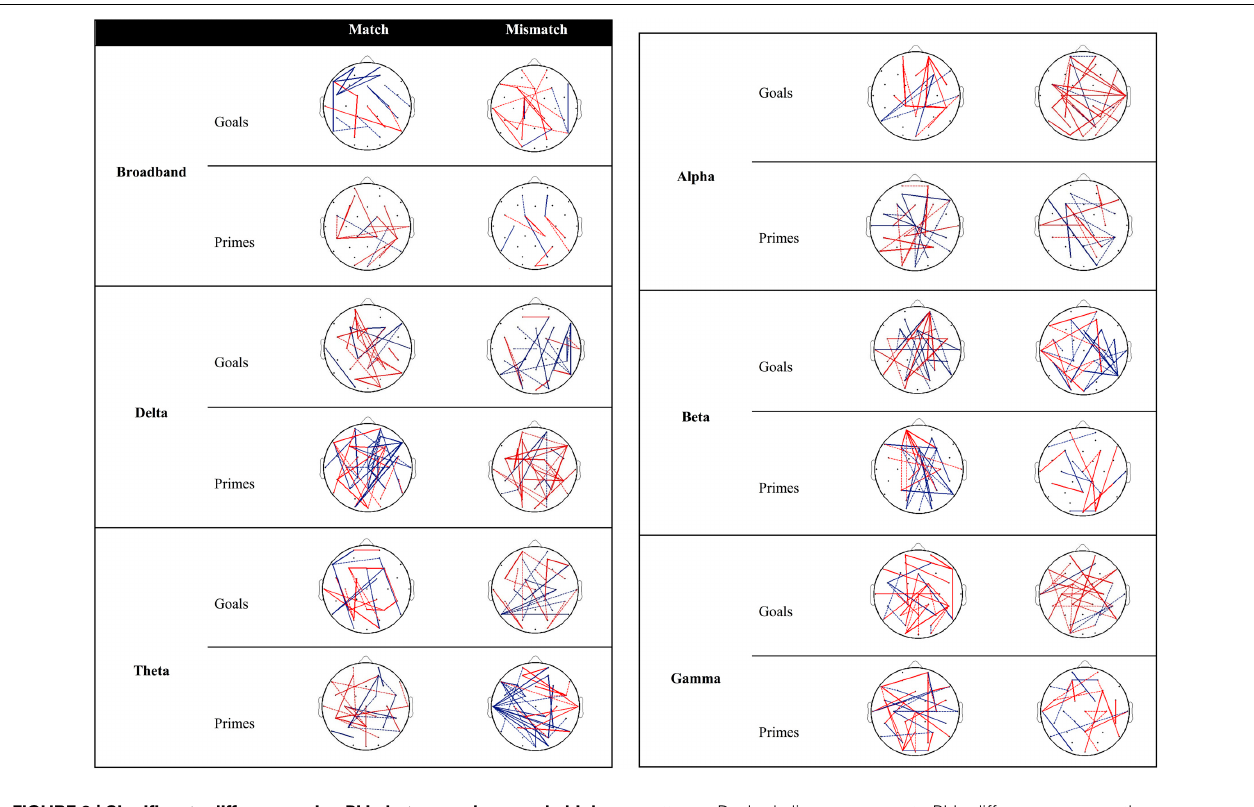
pattern. Dashed lines represent PLI differences near the significance threshold (0 . 02 ≤ p ≤ 0 . 03) whereas solid lines represent connections that are more robust across re-runs of the permutation analysis ( p < 0 .